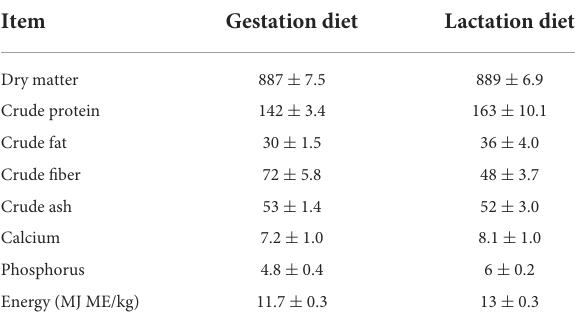
TABLE 1 Nutrient contents in the gestation and lactation diet (pelleted complete feed) in accordance with the analysis (g/kg as